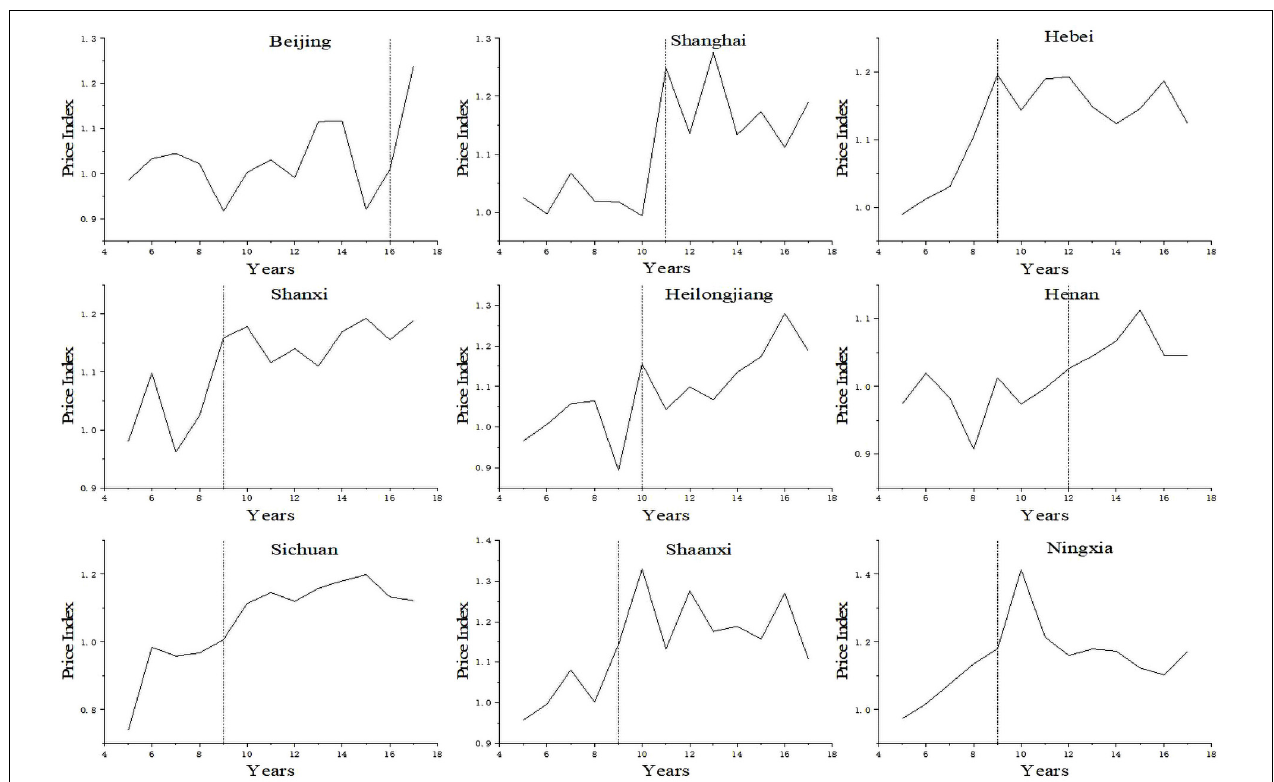
FIGURE 1 | Raw milk purchase price index trends in regions that implemented the